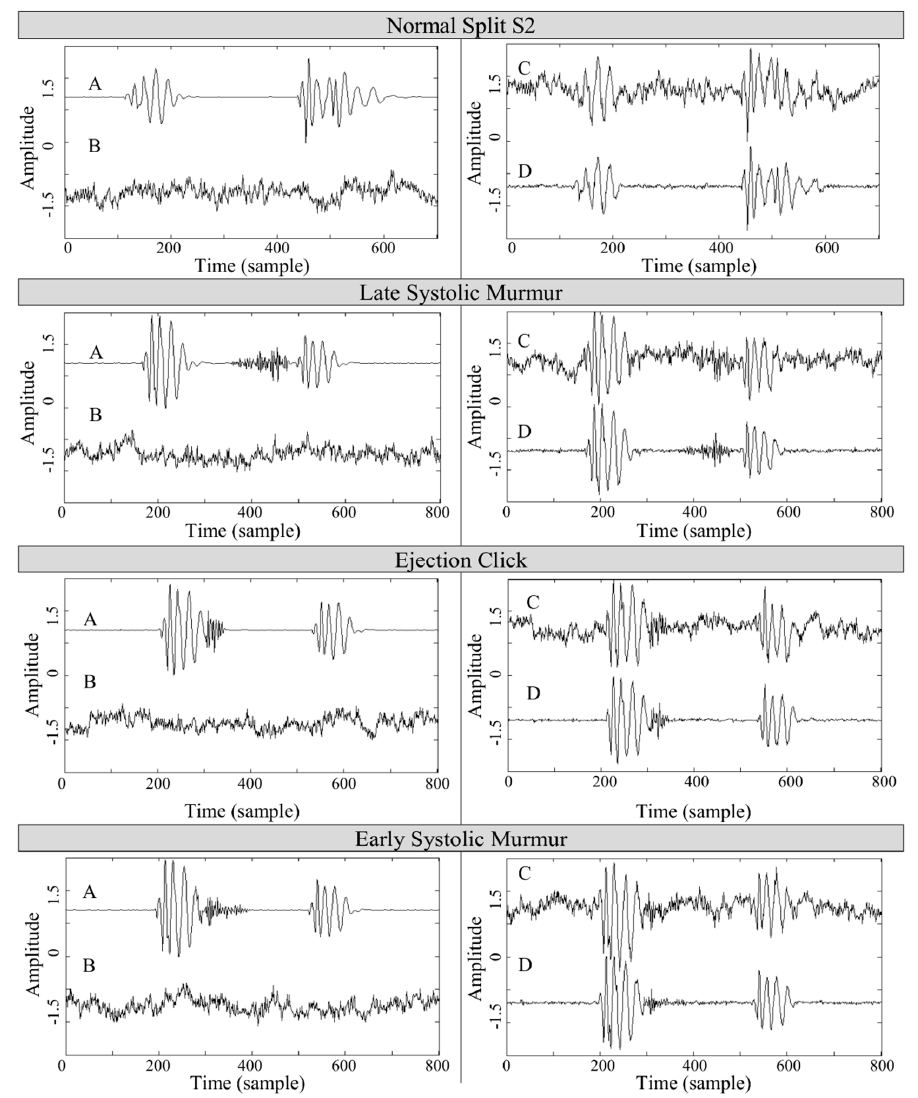
Figure 6. The final results of the filtration process. A—desired signal, B—the pink noise of SNR = 10 dBm, C—noised signal, and D—denoised signal.